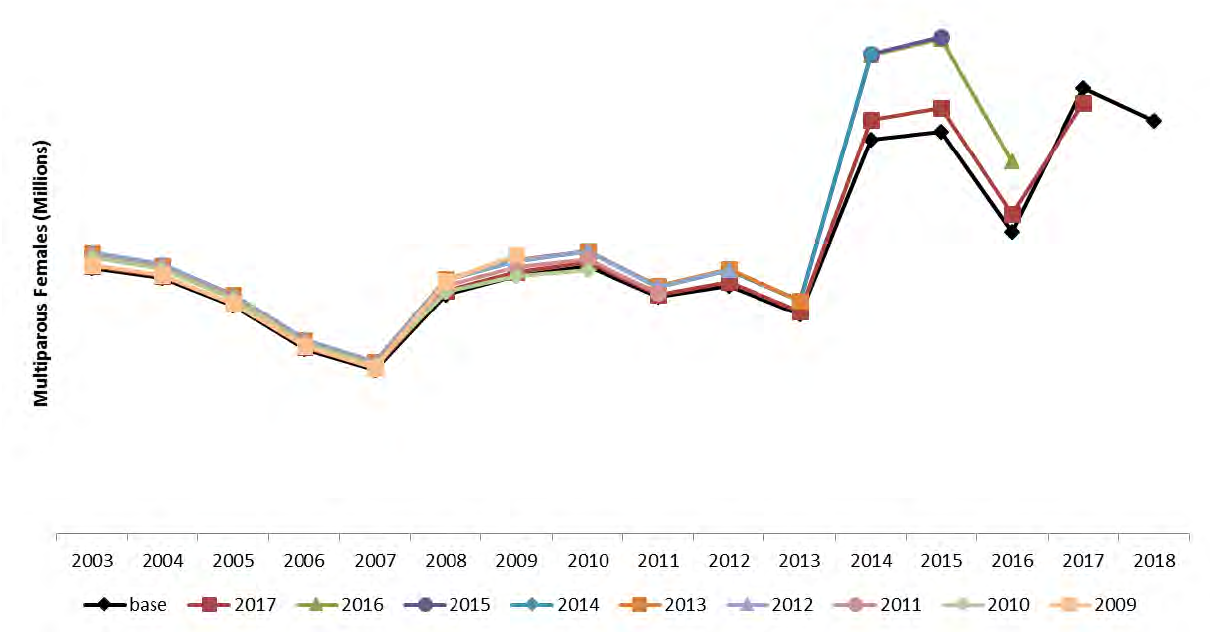
Figure 111. Retrospective peel of estimated multiparous abundance to 2009. Y-axis values have been removed due to CONFIDENTIAL